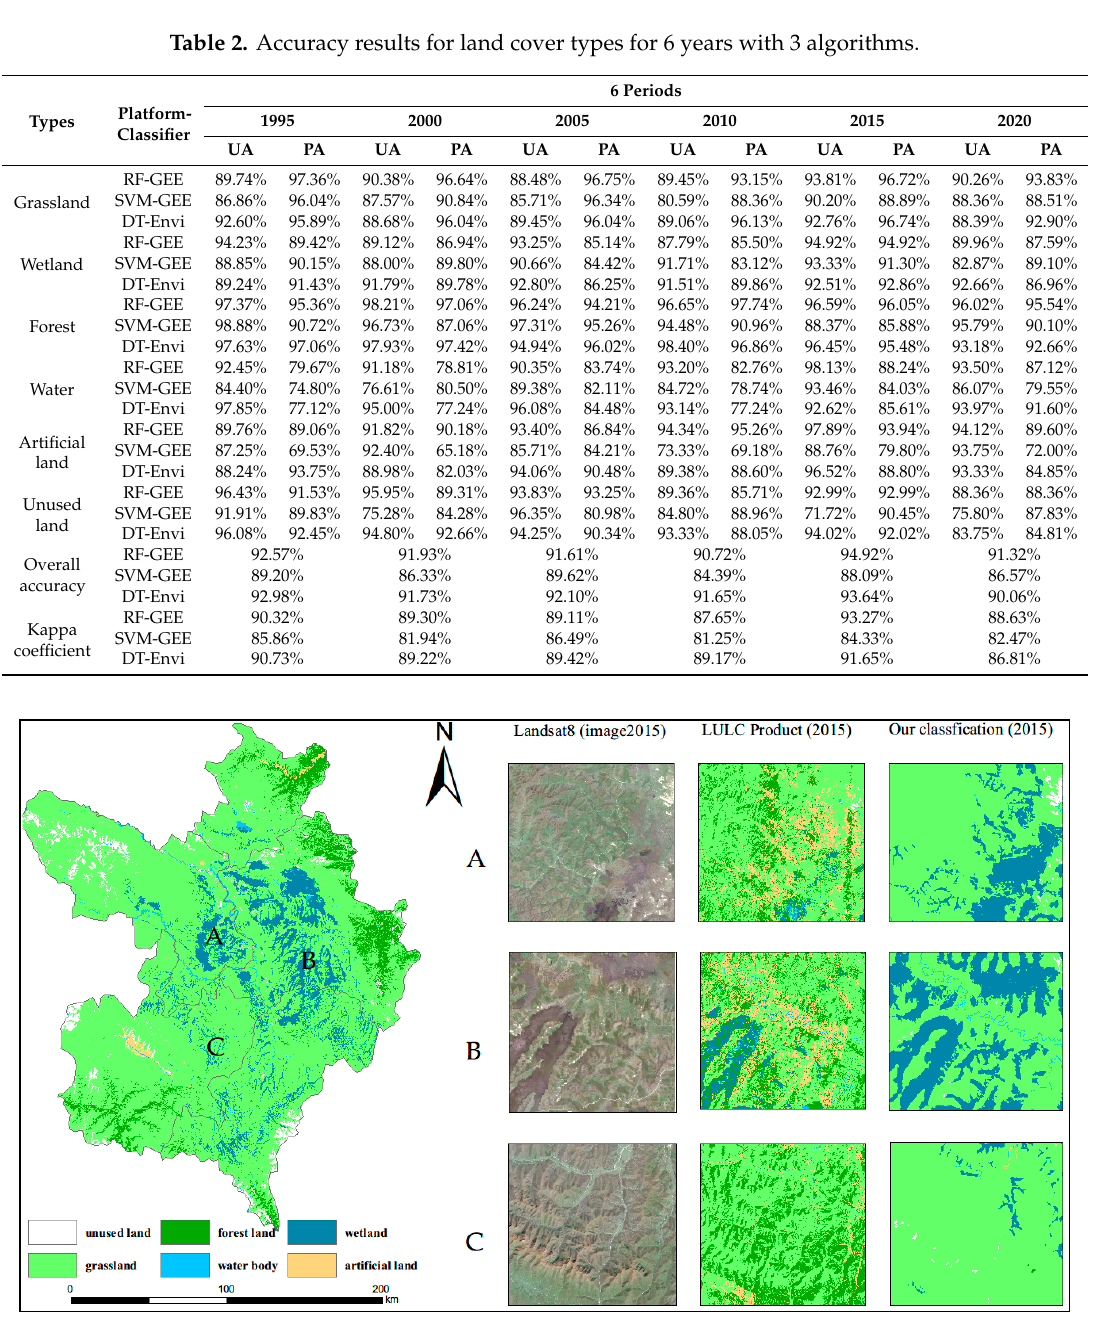
Figure 4. Comparison diagram of classification results (A, B and C refer to three wetland area; left refer to Landsat images in growth season; middle refers to FROM-GLC products; right refers to the classification results of our study).